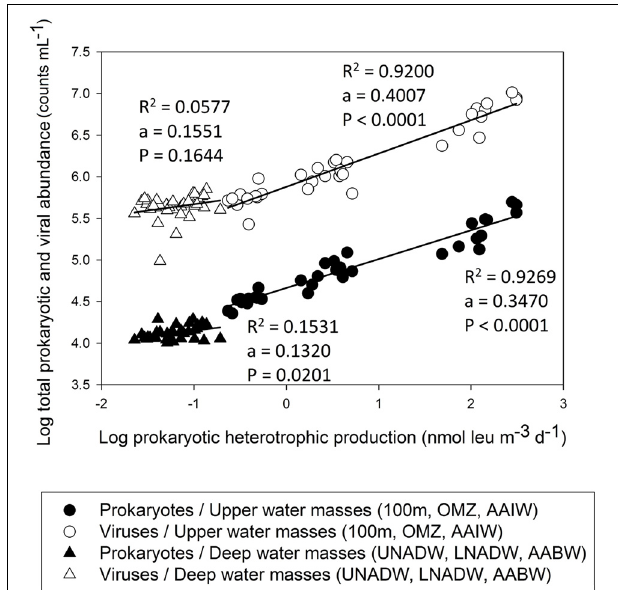
FIGURE 6 | Total prokaryotic and viral abundance versus prokaryotic heterotrophic production throughout the water column in the (sub)tropical North Atlantic Ocean.